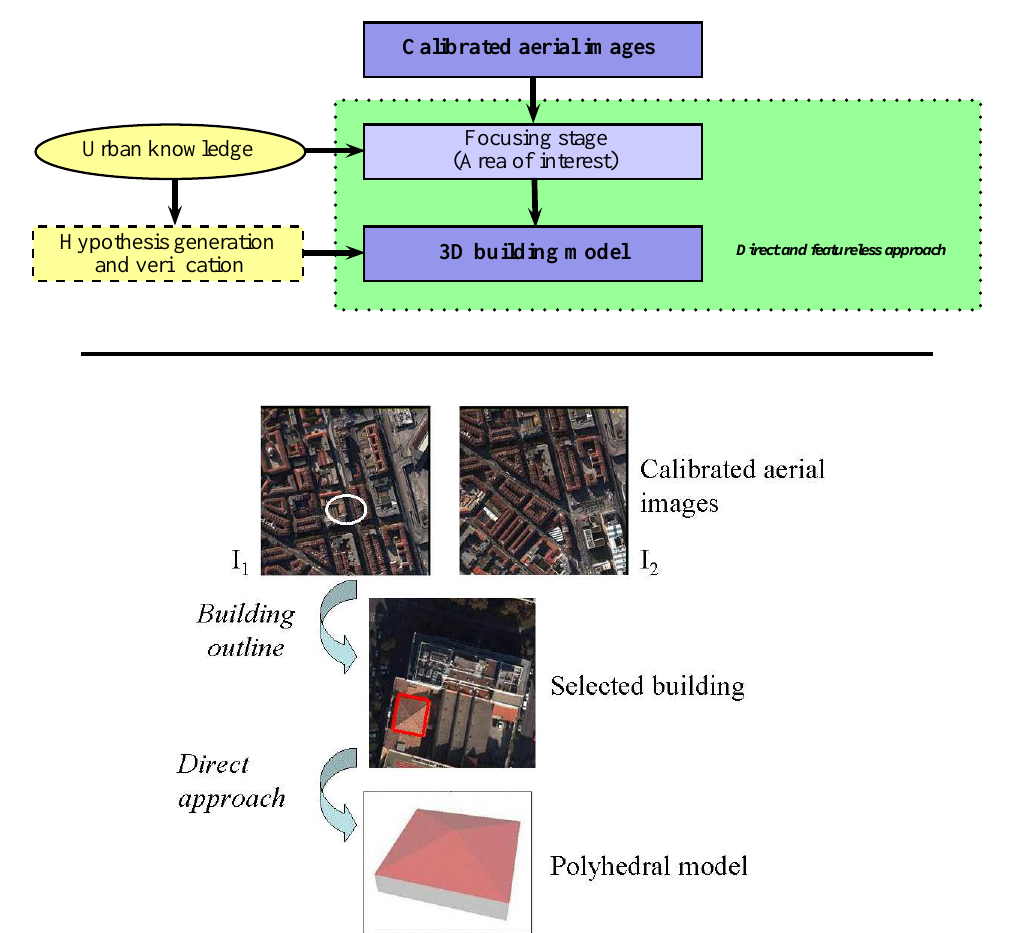
Figure 7. Flowchart diagram of the proposed approach (top) and illustrations of the main steps